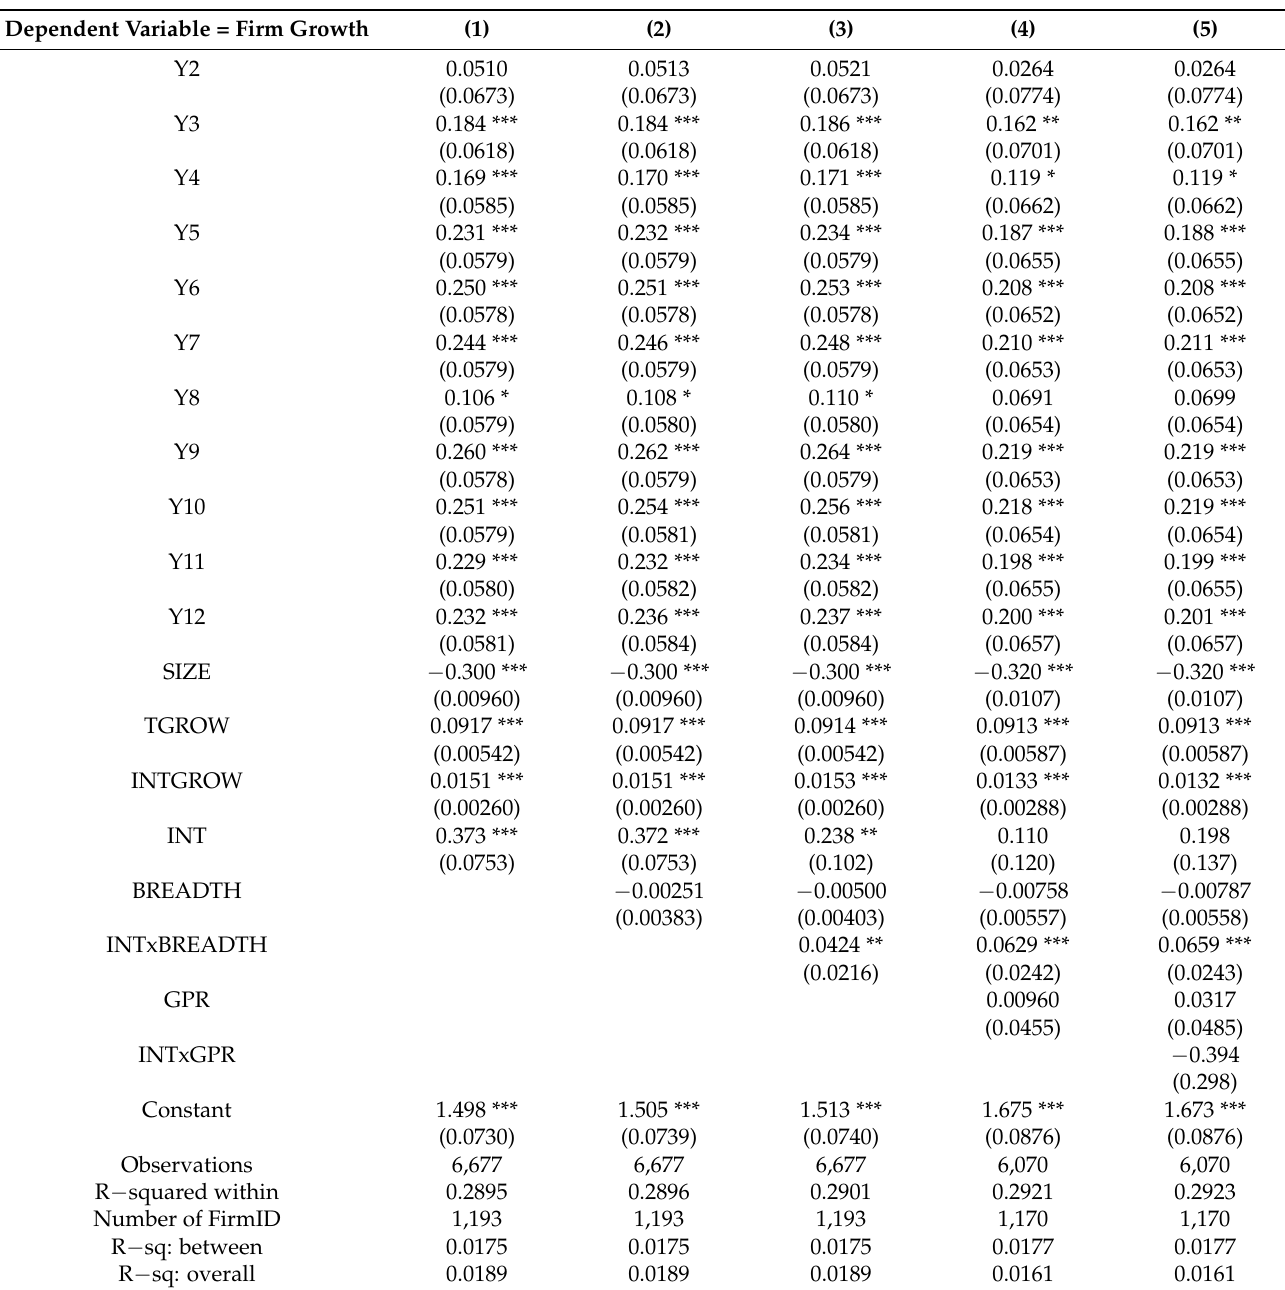
Table 7. Effect of breadth and GPR on firm growth.